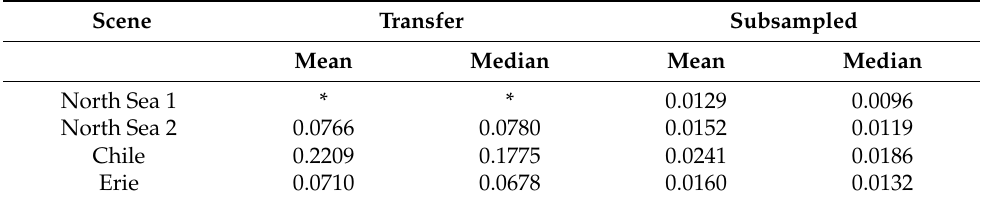
Table 6. Relative quantization error resulting from 32 North Sea 1, or from subsampling one scene with 4096